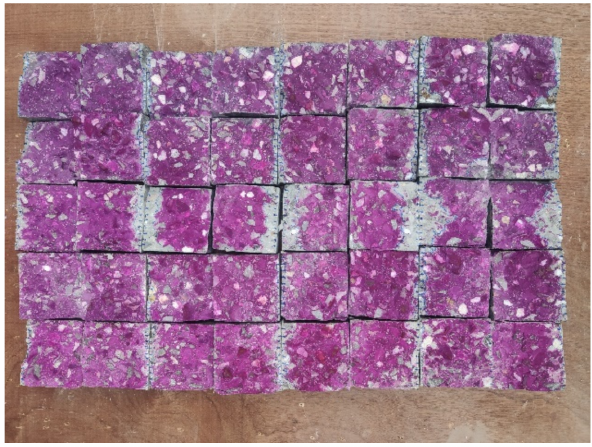
Figure 3. Specimens for carbonation depth